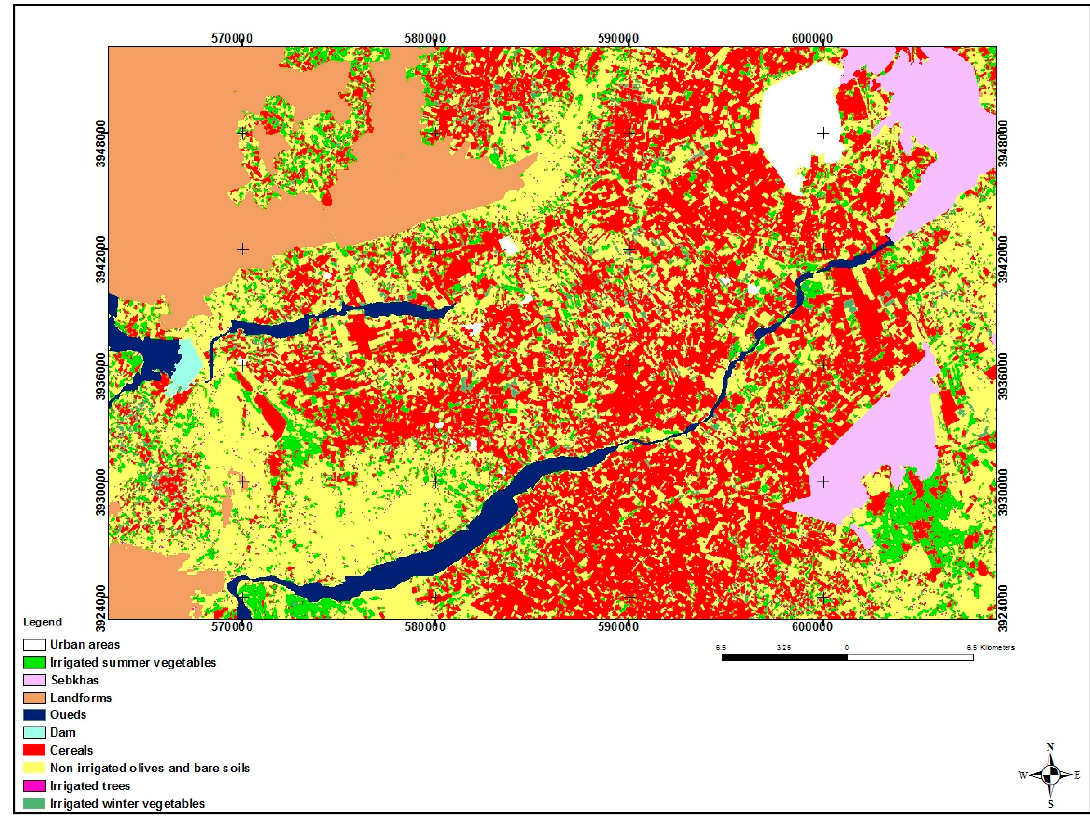
Figure 4. Land use map.